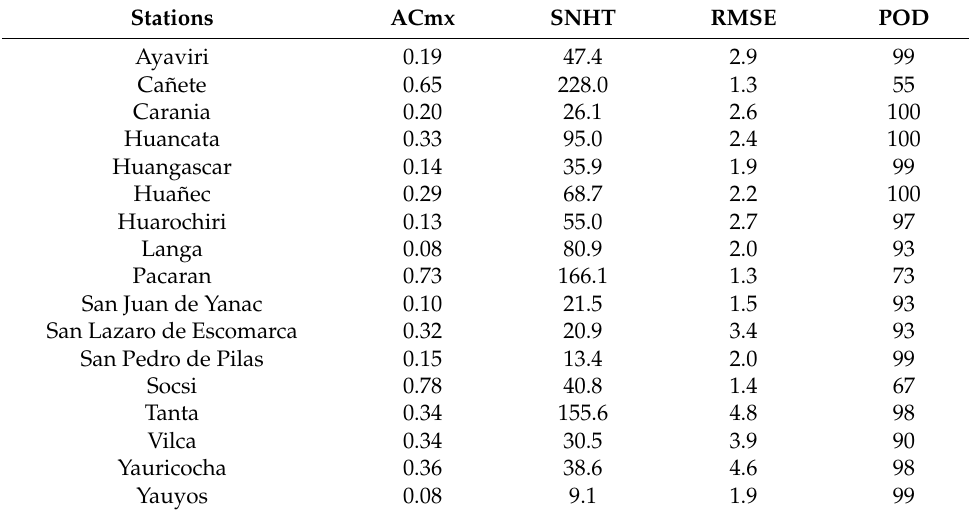
Table 2. Homogeneity analysis statistics for each station.